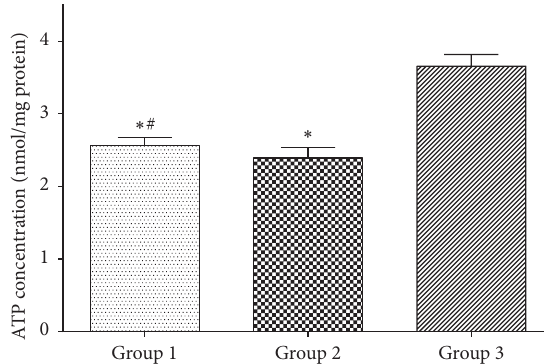
Figure 3: Intestinal mucosal ATP concentration at the end of preservation ( ∗ 𝑝 < 0.05 versus group 3; # 𝑝 > 0.05 versus group 2).